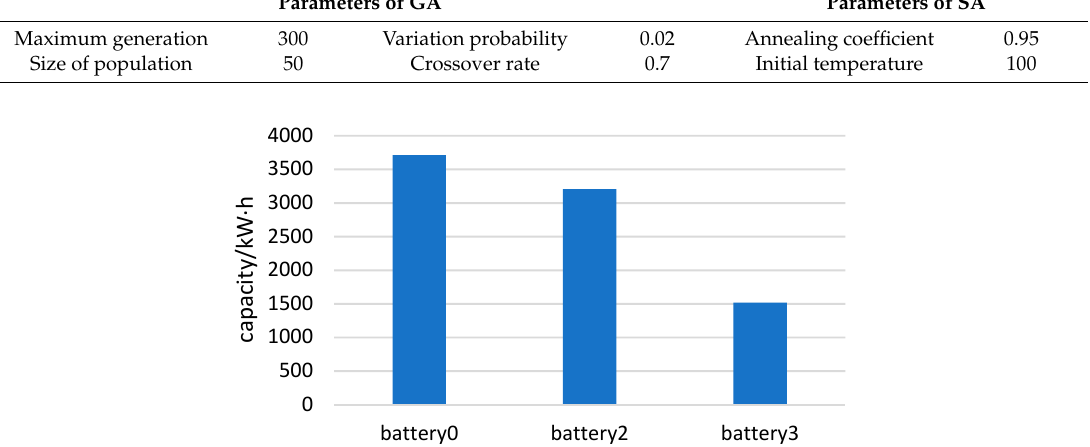
Figure 7. The Energy Storage System’s (ESS) sizing results after the first-stage optimization.